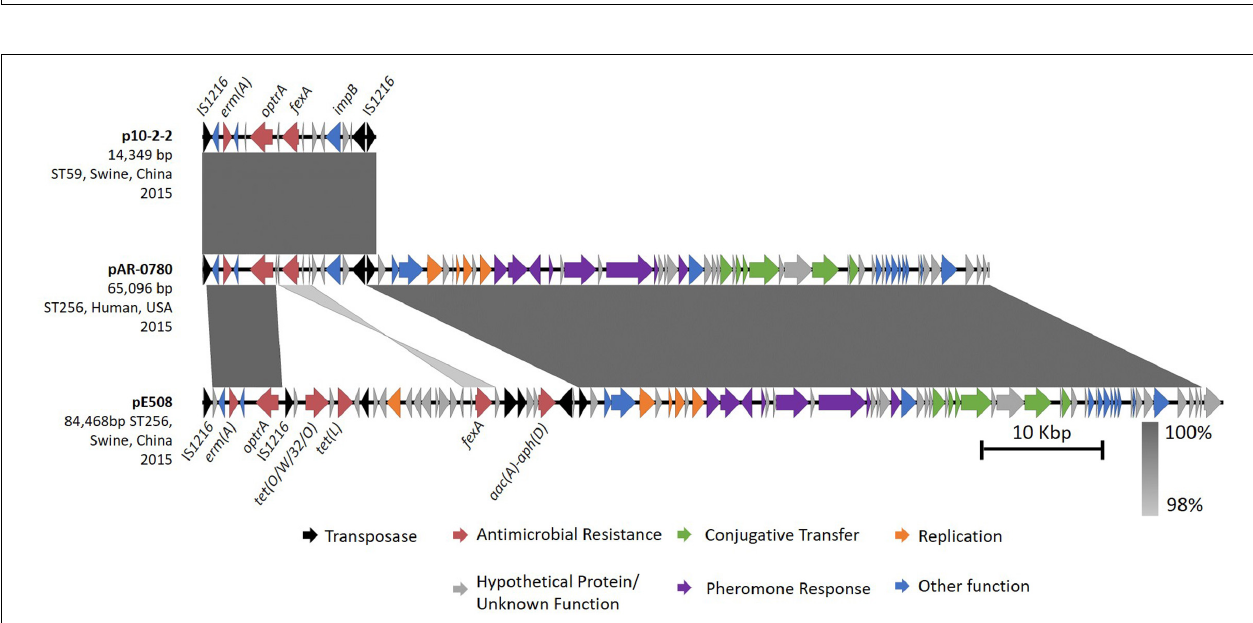
FIGURE 2 | Diagram of AR-0780’s chromosomal transposon, Tn 6674 (12,933 bp). optrA along with the resistance genes spc , erm (A), and fexA, are shown in red. Transposase genes , tnpA, tnpB, and tnpC, are shown in blue. The left and right hexanucleotide sequences marking the left and right junction of the Tn 6674 radC integration site are shown in boxes. The disrupted radC ( (cid:49) radC ) is shown in gray.